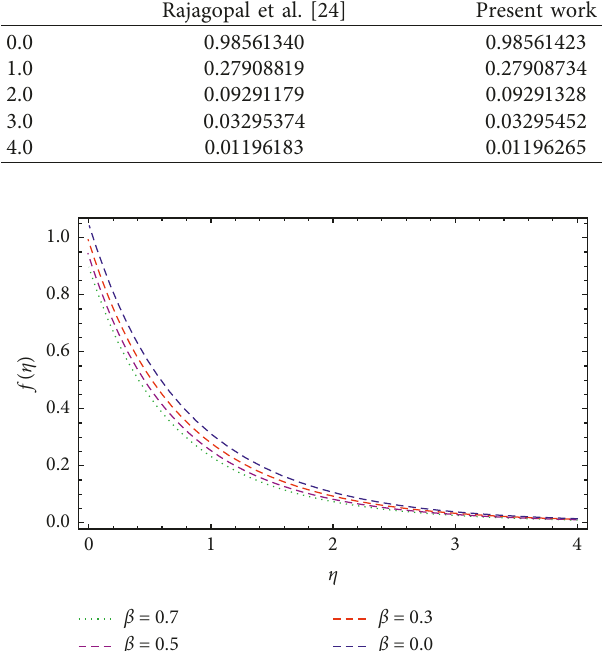
Table 1: Comparison of the present work with the published work. Rajagopal et al. [24]